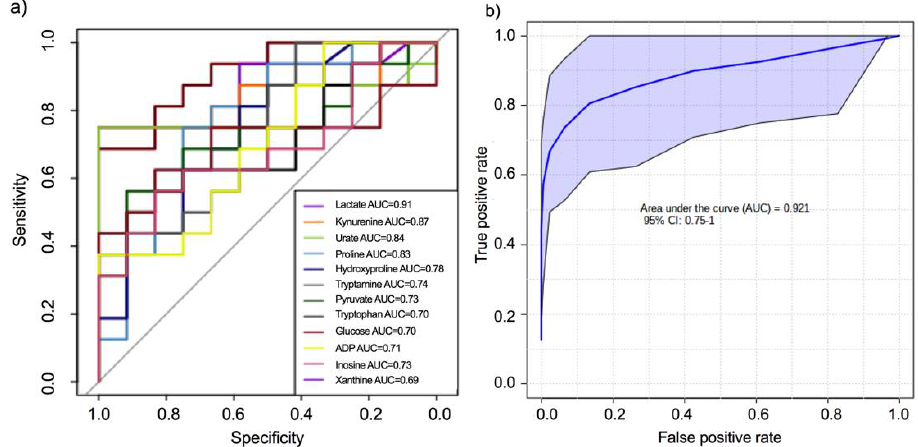
Figure 3. Receiver operating curves of differential metabolites verified by targeted analysis: ( a ) Univariate ROC; ( b ) random forest-based multivariate receiver operating curve combining the 12 metabolites.